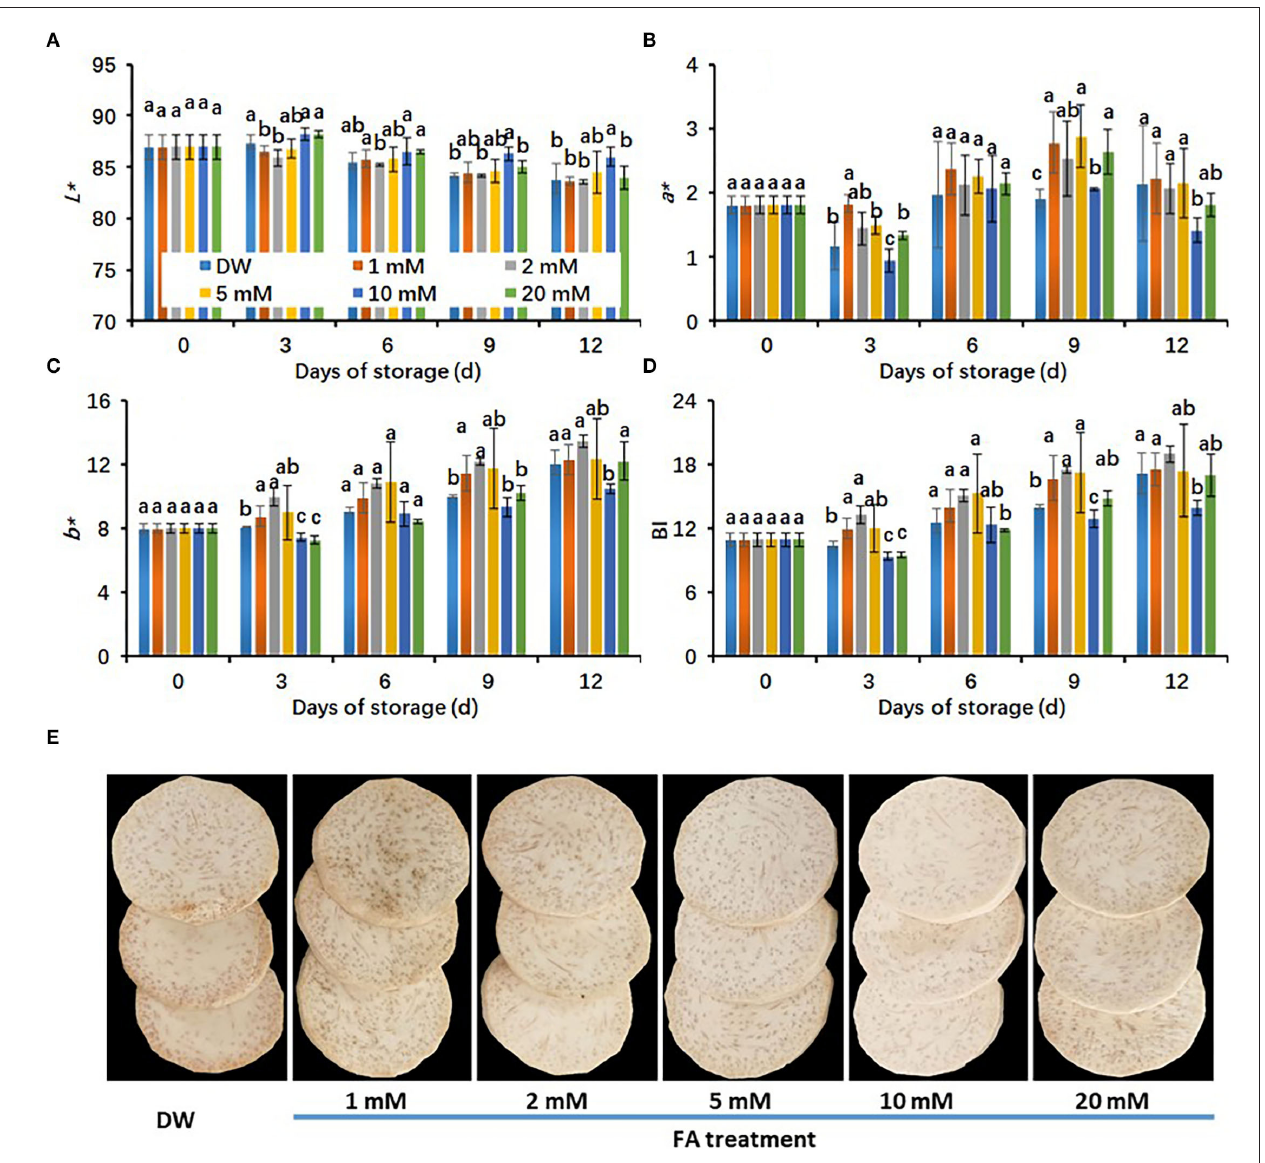
FIGURE 1 | Effects of different concentrations of FA treatments on the browning development of fresh-cut taro during storage at 5 ◦ C. (A) L * value; (B) a * value; (C) b * value; (D) browning index (BI), (E) the representative pictures of fresh-cut taros, which were taken at 12 days of cold storage at 5 ◦ C. Each value is presented as means ± standard deviation (SD, n = 3). Statistical differences ( p ≤ 0.05) between treatments at the same time point are analyzed and indicated using different letters above the bars.